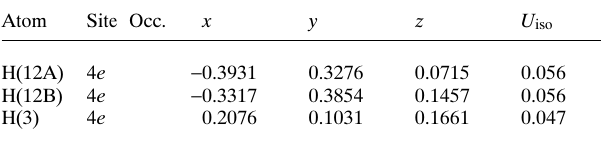
Table 2. Atomic coordinates and displacement parameters (in Å 2 )